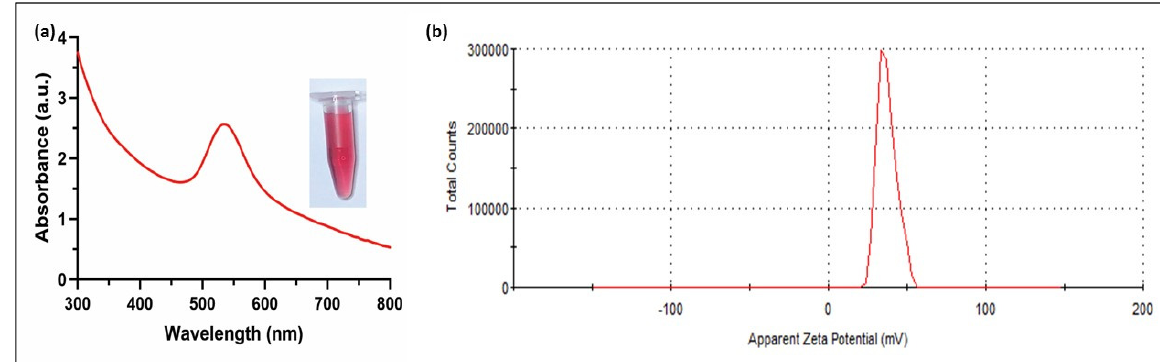
Figure 2. Characterization of C-AuNPs ( a ) UV-visible spectrum with maximum absorbance at 530 nm, Inset micro-centrifuge tube represents the wine red colloidal solution of freshly synthesized C-AuNPs ( b ) Zeta Potential denotes the surface charge of +39.4 ± 2.05 mV (average of three readings).